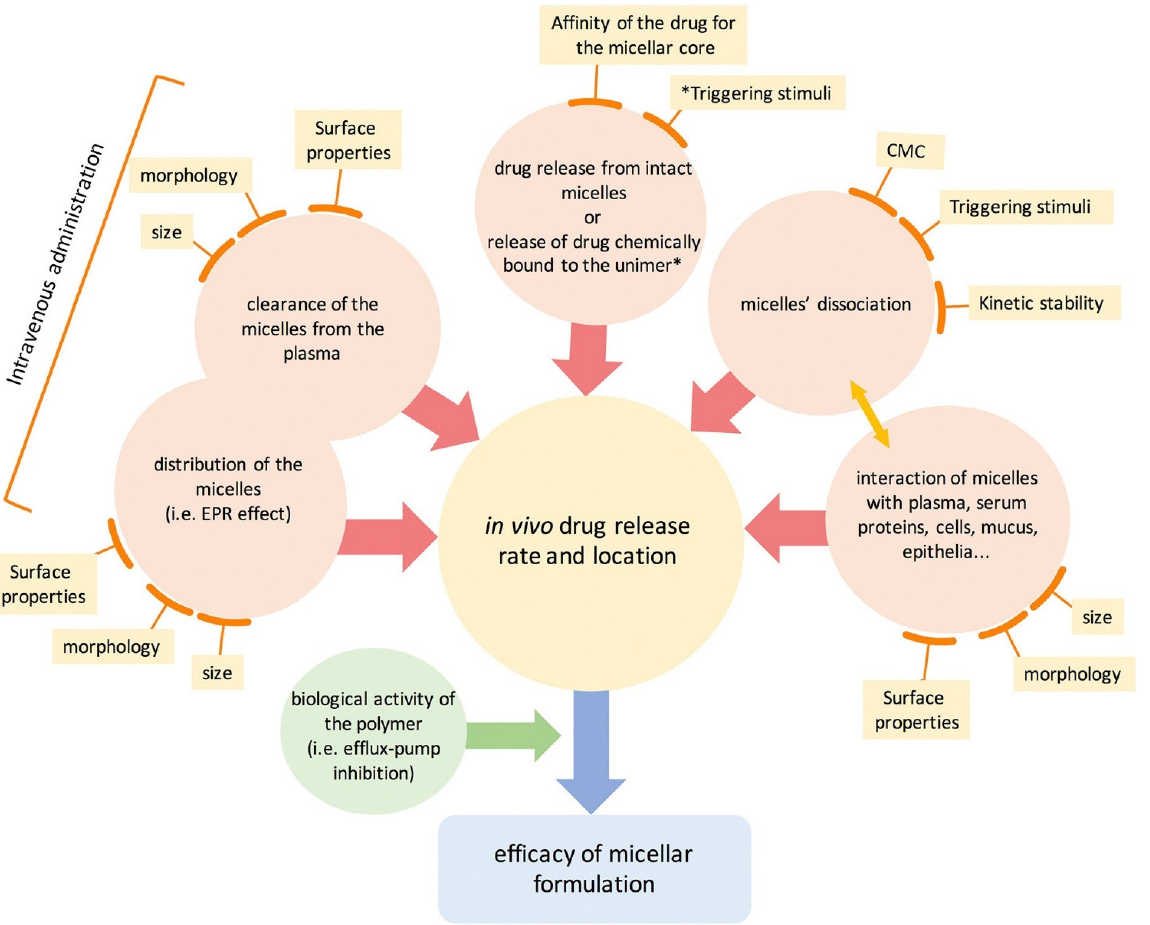
Figure 2. Schematic representation of the mechanisms of polymeric micelles. All mechanisms either work in a standalone manner or are mutually influenced by various conditions; unimer*, single unit of amphiphilic block; * Triggering stimuli represent various strategies, such as temperature, pH, enzymes, and magnetism. Note: EPR, enhanced permeability and retention; CMC, critical micellar concentration. Reprinted from [37] CC BY 4.0 License.